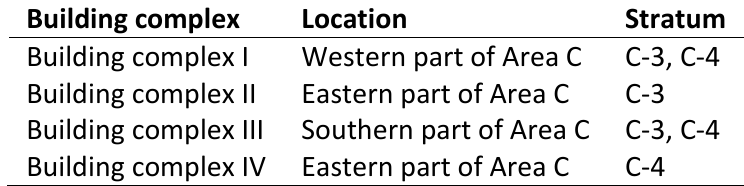
Table 1: The residential units of Area C at Tel